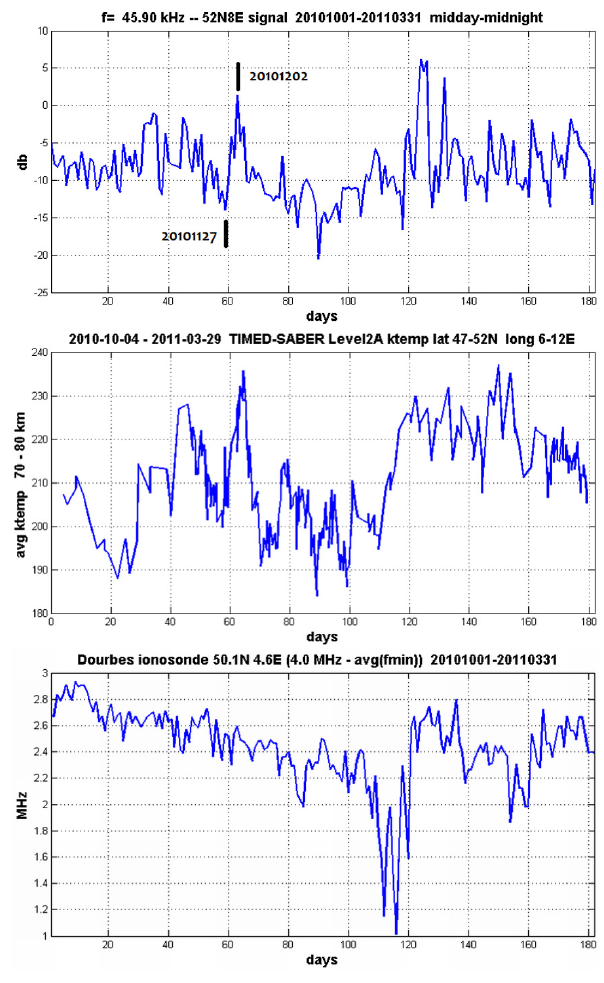
Fig. 4. Top: NSY log amplitude difference midday-midnight (2h averages); the 2 marks refer to the radio signal amplitude plots in Fig. 1. Middle: SABER mesosphere kinetic temperature: 70–80km average for the region 47–52 ◦ N, 6–12 ◦ E (containing the Rx ori- ented half of the propagation path) during winter 1 September–31 March 2011. Note some correlating trends. Bottom: HF absorption data from the Dourbes ionosonde (Belgium, 50.1 ◦ N, 4.6 ◦ E). Plot- ted is (4Mhz – f min ), f min : minimum ionogramm echo frequency; f min is large during strong absorption